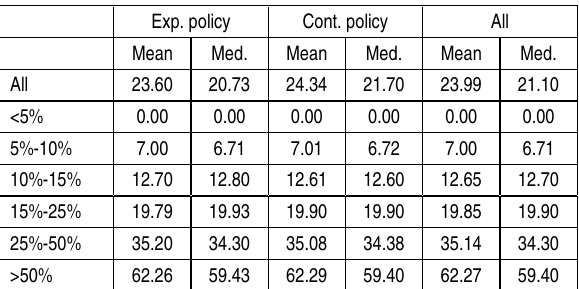
Table 4. Sum of blockholdings (%) across monetary policy